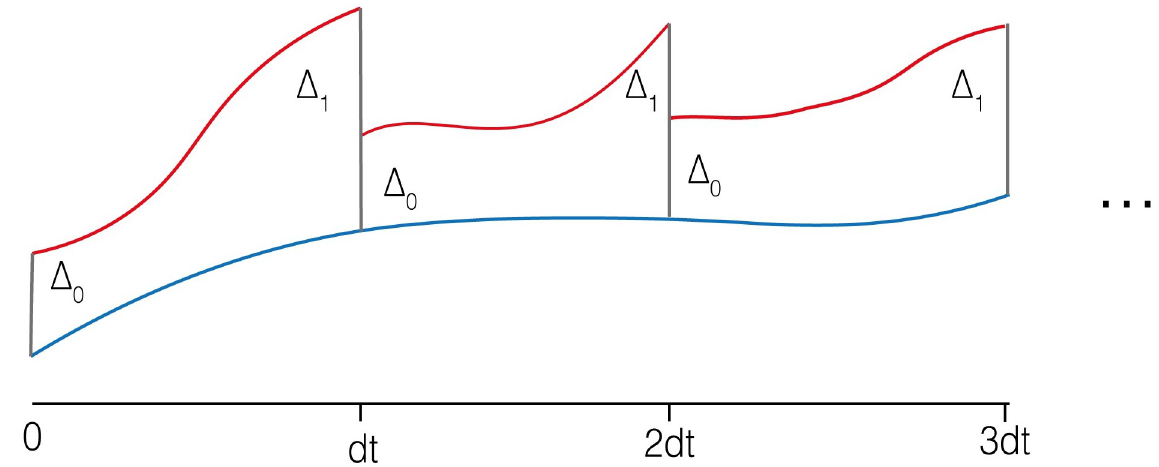
Fig 6. Illustration of dual-orbit algorithm used to calculate the λ 1 . Two orbits with an initial state separation of 4 0 are followed. After each time step measure the separation, 4 1 , is measured. The perturbed orbit (red) is readjusted to prevent excess separation. The average rate of separation between the two orbits corresponds with the λ 1